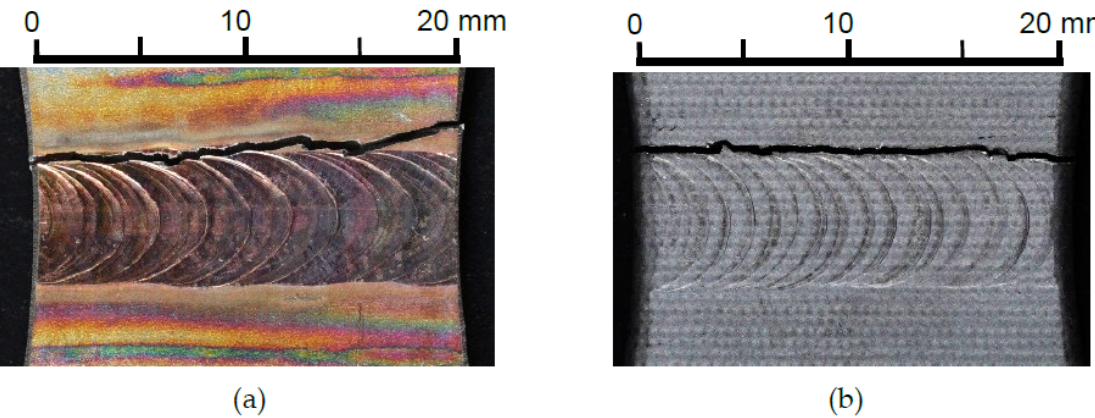
Figure 10. Fractured surface of a welded part. ( a ) Non-peened specimen ( σ a = 229 MPa, N = 688,800); ( b ) specimen treated by laser cavitation peening ( σ a = 319 MPa, N = 516,300).